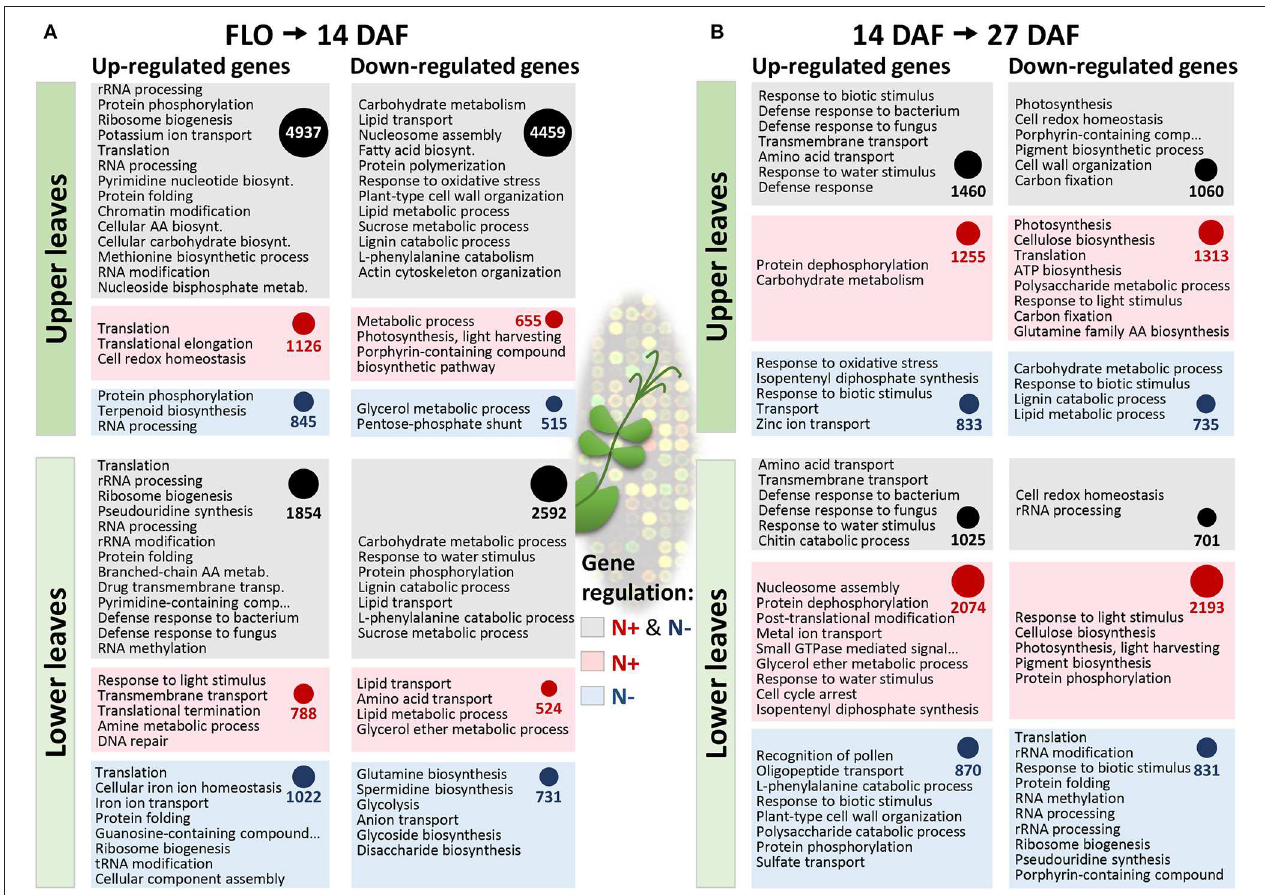
FIGURE 2 | Transcriptome changes in leaves of vegetative (lower leaves) and reproductive (upper leaves) nodes during pea seed development and in response to nitrate availability. The number of genes whose expression varied (Bonferroni-corrected P -value < 0.05) between the beginning of flowering and 14 days after flowering ( A , 14 DAF) and/or between 14 and 27 days after flowering ( B , 27 DAF). The number of genes whose expression varied regardless of nitrate nutrition are shown in gray boxes, while the number of genes whose expression varied specifically under nitrate-supply (N + ) or nitrate-deprivation (N–) are shown in red and blue boxes, respectively. The circles are proportional to the number of genes in each box. GO terms significantly enriched (Fisher P values < 0.005) in each gene list are sorted according to P values (lowest at the